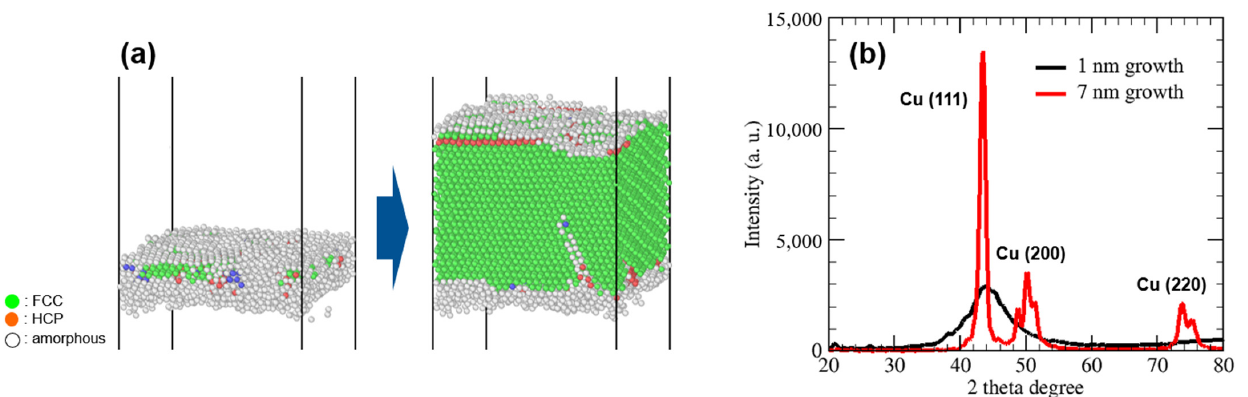
Figure 5. ( a ) Crystallization of Cu film during deposition process (substrate part was not shown for clear comparison). In the 1 nm thickness, the film shows an amorphous structure (left), but the film is crystallized when it grows as 7 nm thickness (right) ( b ) X-ray diffraction (XRD) patterns of Cu film grown in the simulation.